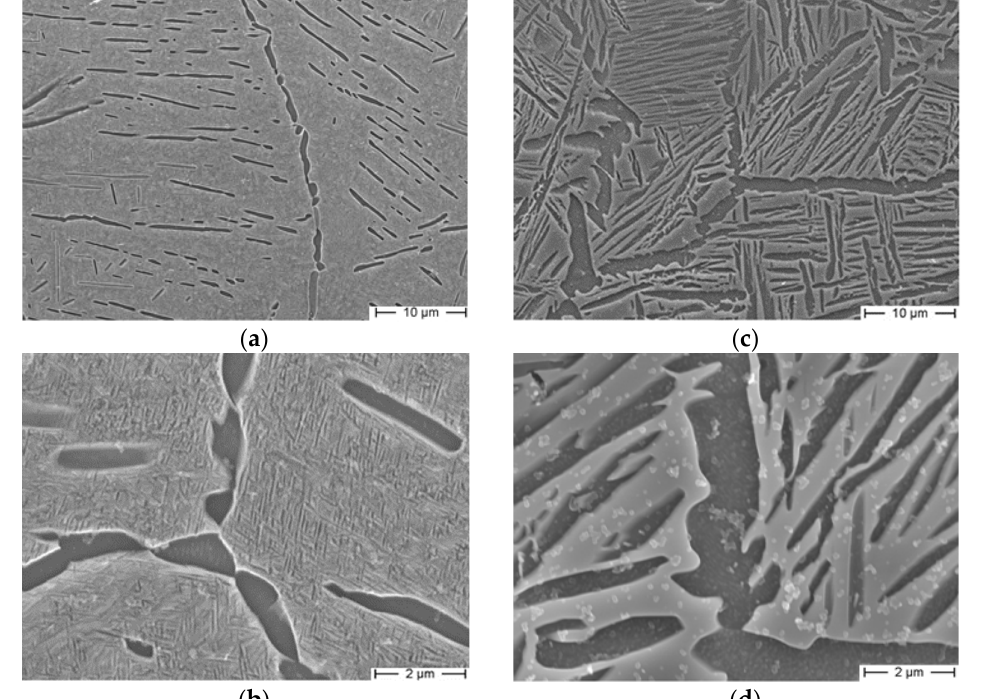
Figure 8. Different microstructures of an EB-PBF Ti-5553 alloy using E L = 600 J/m. ( a , b ): STA; ( c , d ): BASCA.